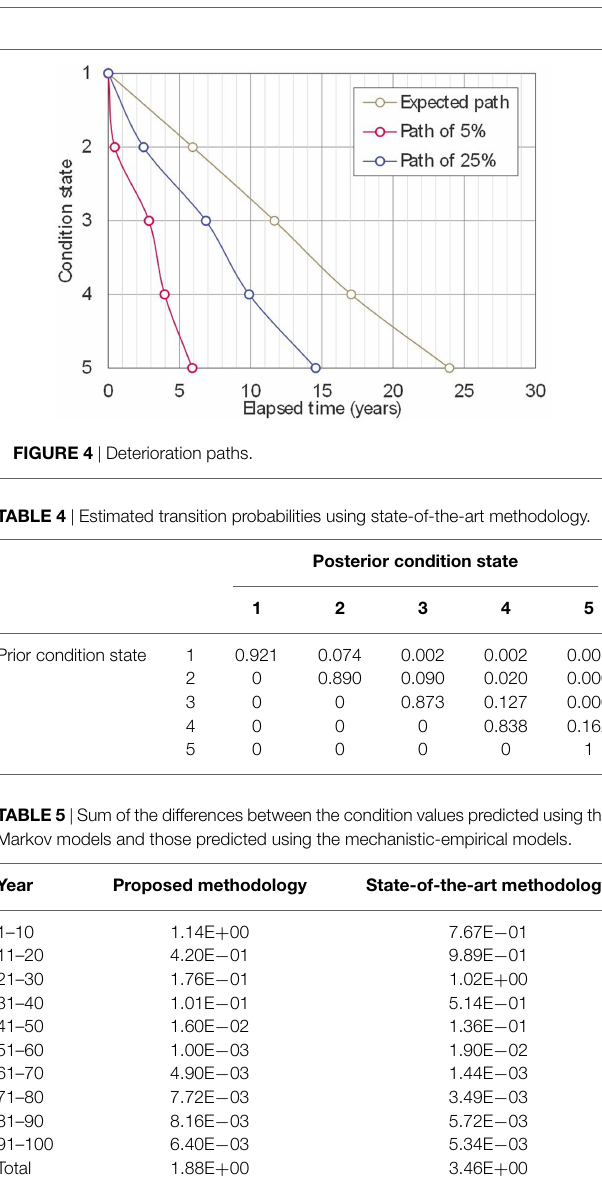
o a 90% Bayesian credible interval, [ T 5 ; T 5 ] (with [ T 5 ; T 5 ] =